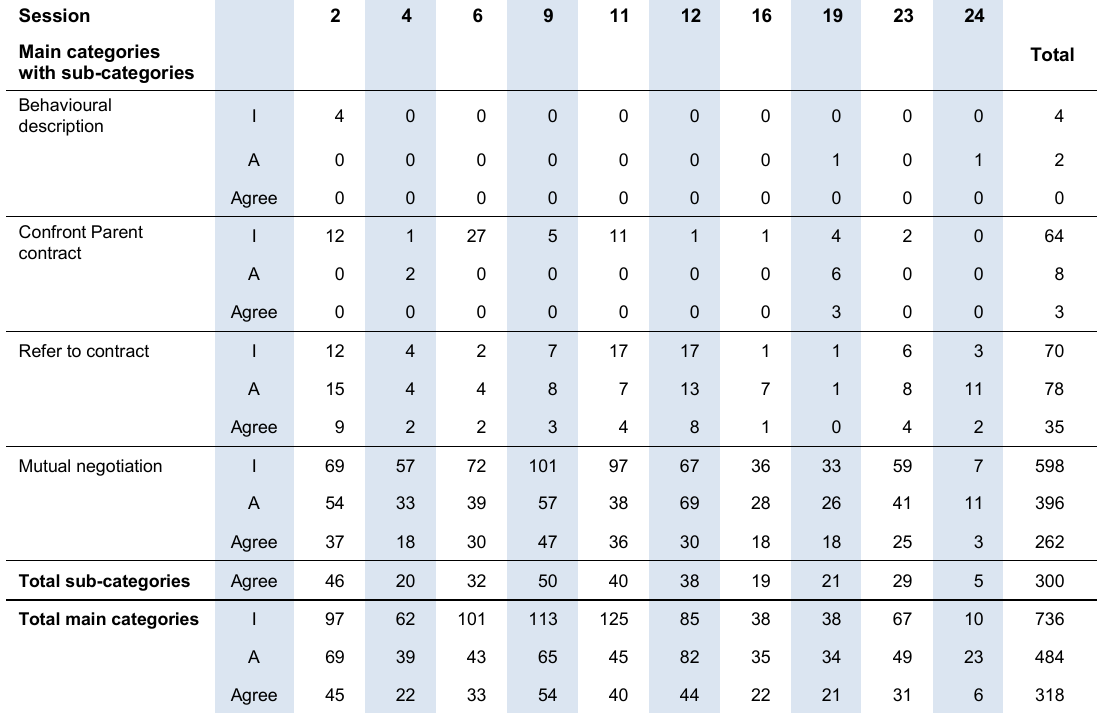
Table 4: Examples of the main Contract category and 4 sub-categories with assessors’ individual and matching codings